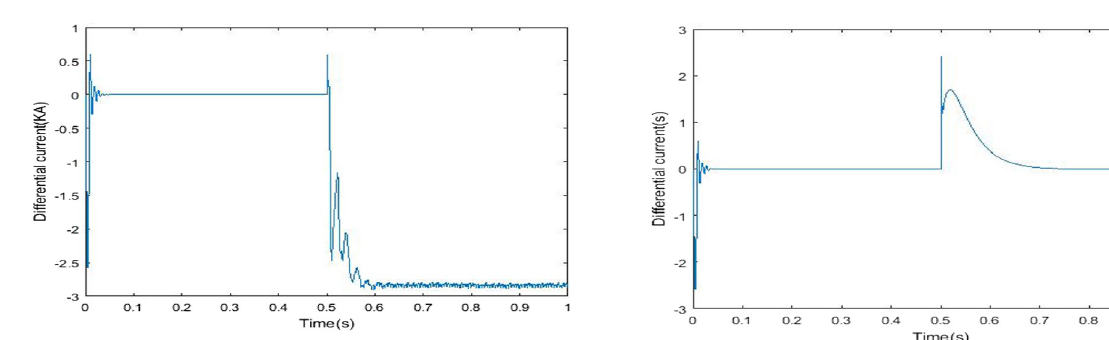
Fig. 6 Positive to ground fault on HVDC line at 25 km